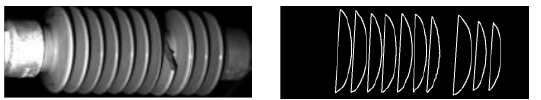
Figure 14. Insulator with large damage range and its contour extraction results.